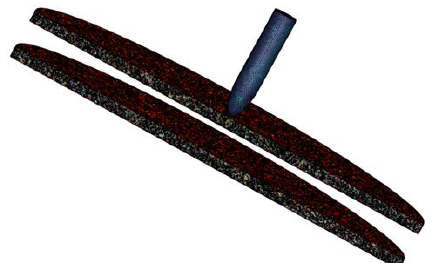
Fig. 6. The geometry of the 2D problem of perforation of a barrier from two spaced heterogeneous plates at distance of 24 mm.